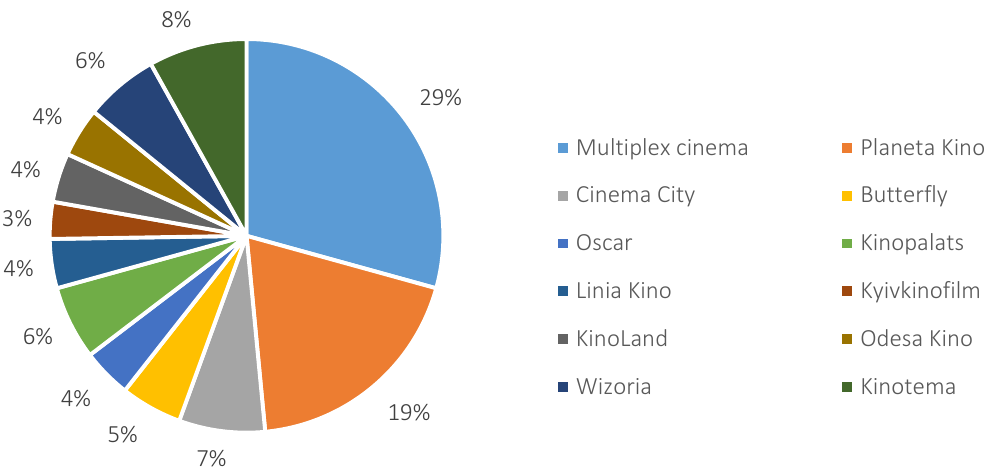
Source: Developed by the